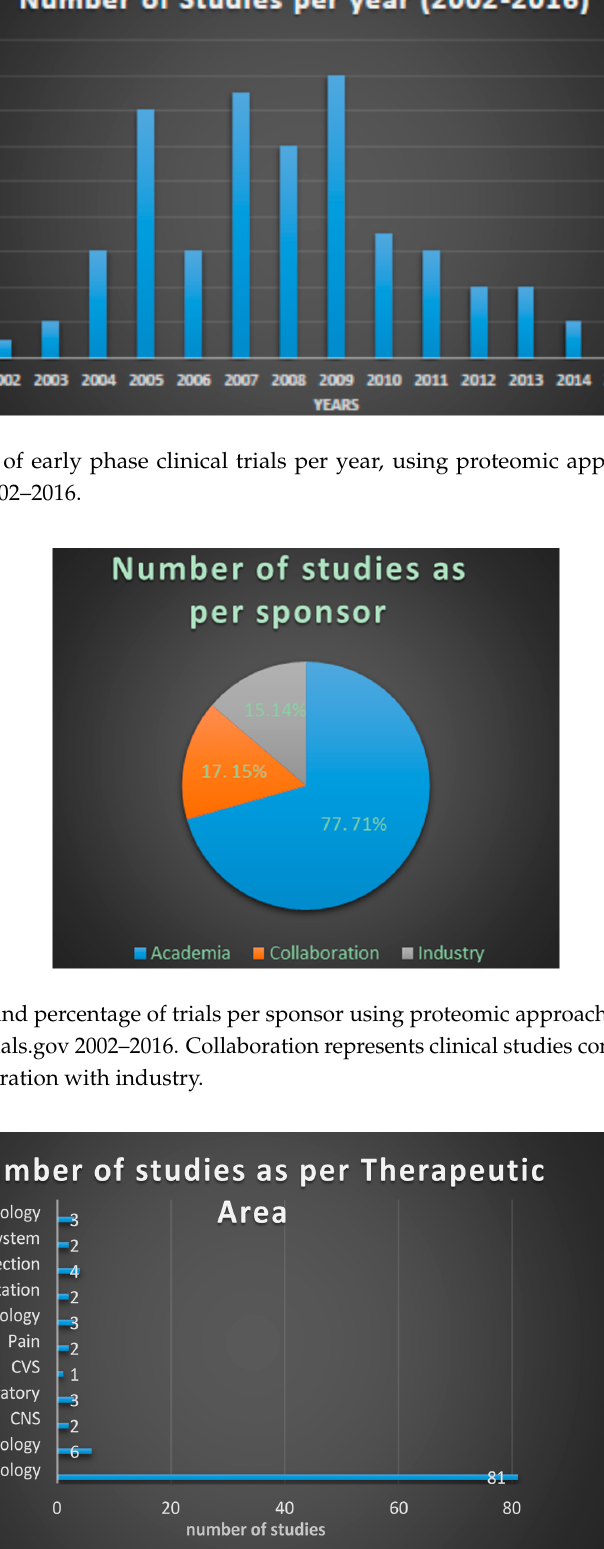
Figure 3. Number of studies as per therapeutic areas utilizing the proteomic approaches. Data from clinicaltrials.gov 2002–2016.